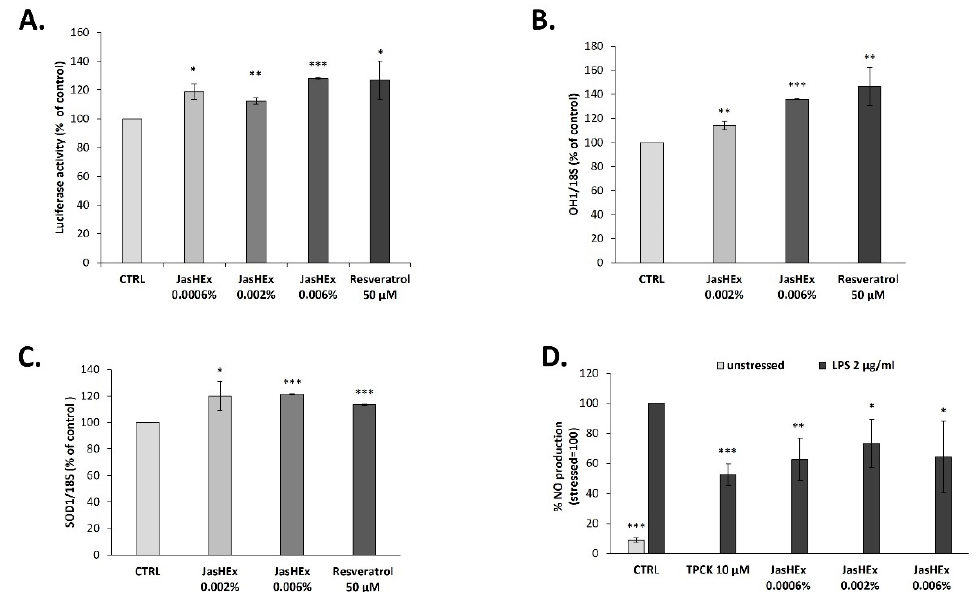
Figure 4. Bar graphs showing JasHEx effect ( A ) to activate Nrf2/ARE signaling, ( B ) to increase OH-1 and ( C ) SOD-1 gene expression in HaCaT cells and ( D ) to reduce NO production in LPS-stimulated RAW 264.7 cells. The bars represent the standard deviations and the asterisks indicate significant variations according to Student’s t-test (* p < 0.05, ** p < 0.01, *** p < 0.001).